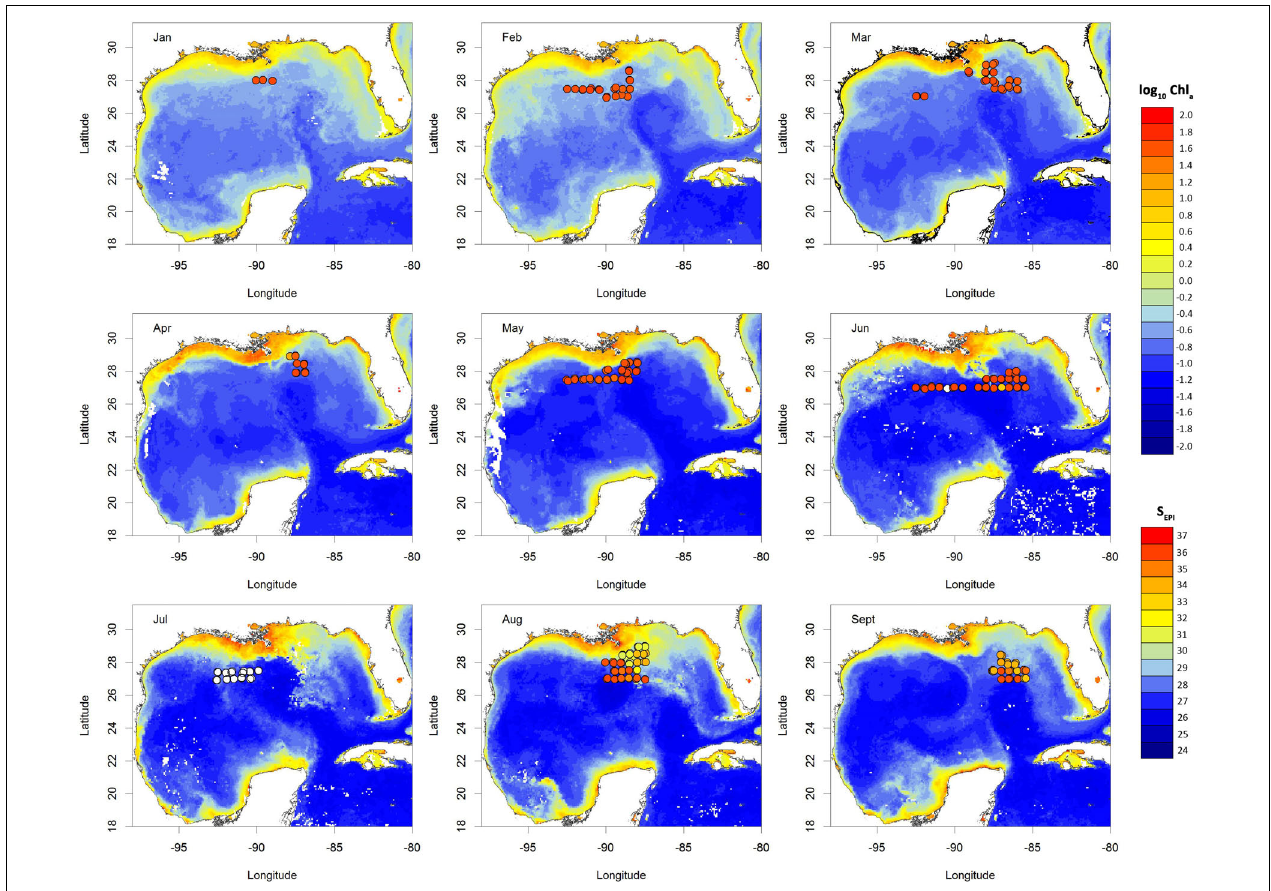
FIGURE 1 | Maps showing the satellite-derived log 10 Chl a concentrations across the GoM per month. Each point is a MOCNESS sample, colored according to the S EPI values recorded by the MOCNESS sensors at the time of collection. White points indicate no MOCNESS sensor data were available. Chart datum: WGS84.